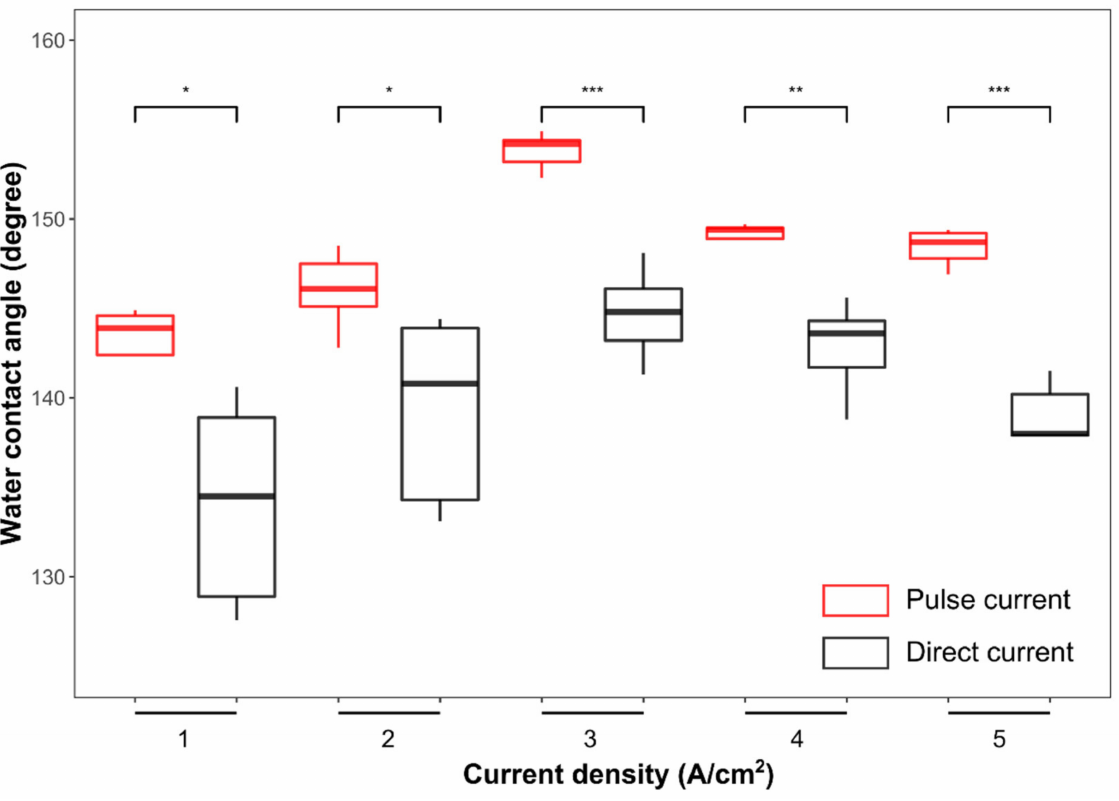
Figure 8. Boxplot comparing the WCA of Ni-Co/WS 2 nanocomposite coatings prepared by different electrodeposition methods. * p < 0.05, ** p < 0.01, *** p < 0.001, two-sided student’s t -test.